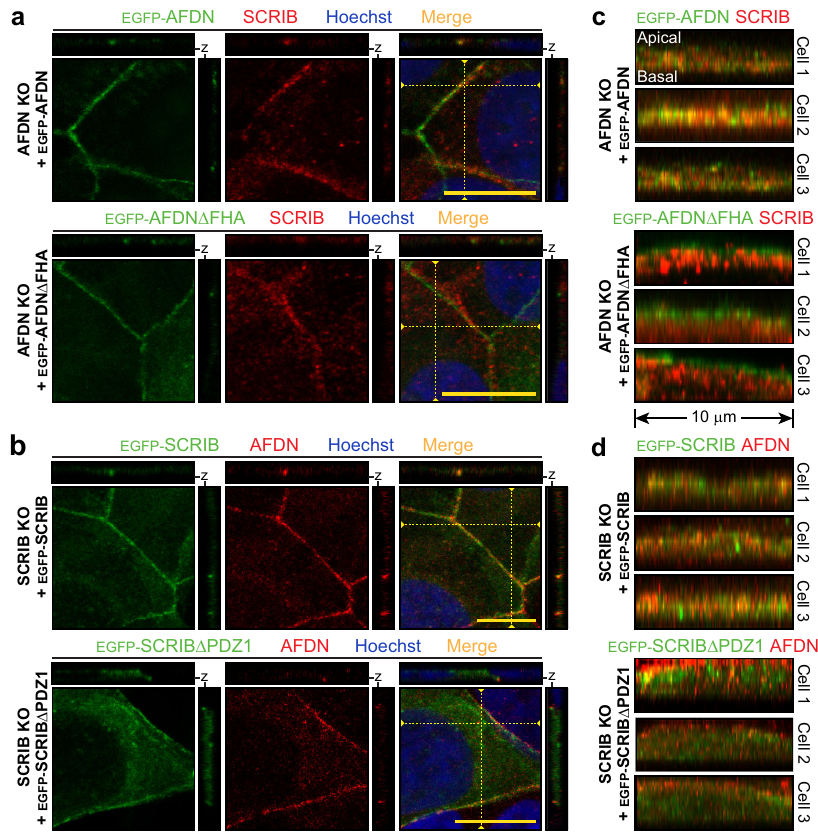
Fig.7|Co-localizationofSCRIBandAFDNisdependentontheirPDZ1andFHA domains, respectively. a Expression of EGFP-AFDN in AFDN KO MCF7 cells restores endogenous SCRIB localization at cell contacts. SCRIB is also recruited to cell contacts in AFDN KOcellsexpressing EGFP-AFDN Δ FHA but appears poorly co- localizedwithAFDN.Projectionsof z -stacksareat right and top andtheirpositionis marked withadashedyellow line inthe merged image.Scalebars represent 10 µ m. b EGFP-SCRIB co-localizes with endogenous AFDN in SCRIB KO MCF7 cells. EGFP- SCRIB Δ PDZ1 is also enriched at cell contacts in SCRIB KO cells. Projections of z -